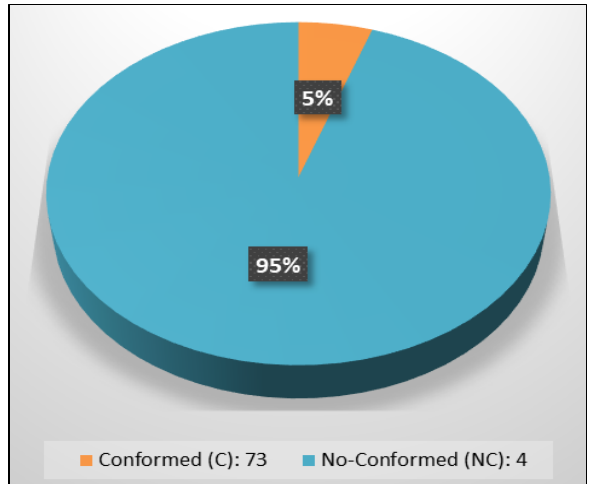
Figure 2: Evaluation of the results of applying the NR-20